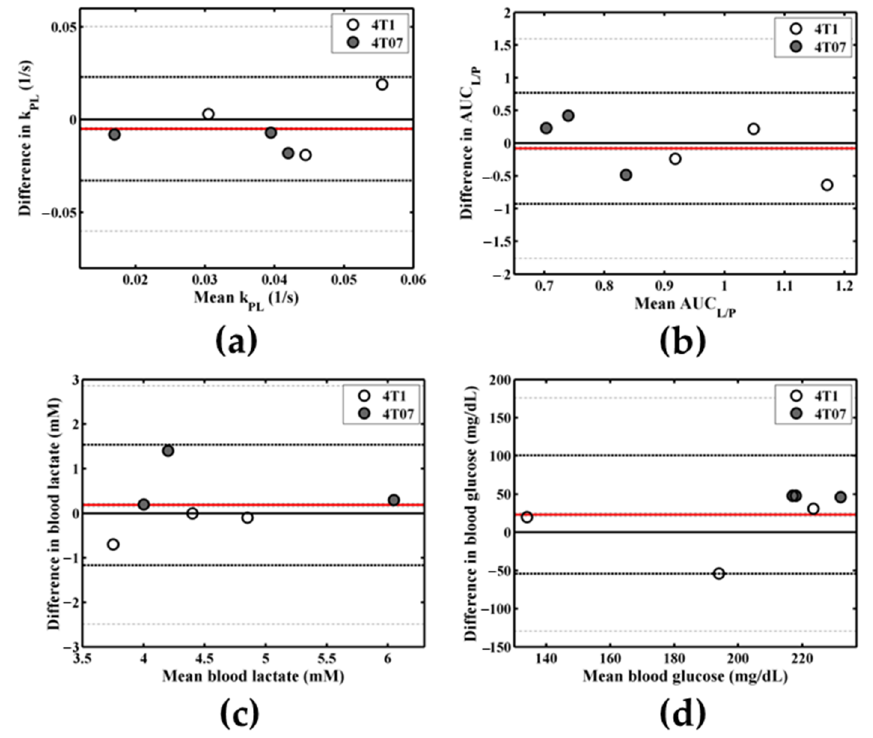
Figure A3. Bland–Altman repeatability plots for k PL ( a ), AUC L/P ( b ), blood lactate level ( c ), and blood glucose level ( d ) including the limits of agreement (dashed black lines), 95% confidence intervals for the limits of agreement (dash-dot gray lines), and bias (solid red line).